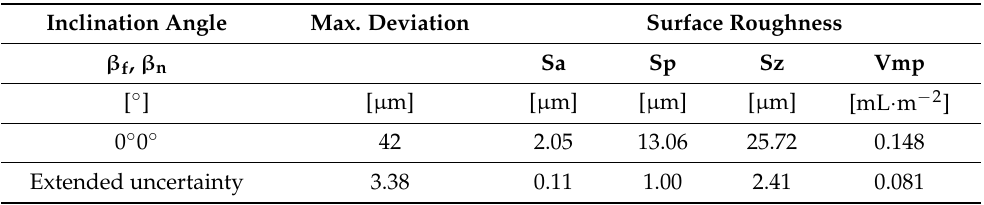
Figure 20. Surface roughness (Sa—Arithmetical mean height of the scale-limited surface) dependence on tool axis inclination angle. Table 3. Maximum deviation and surface roughness during 3-axis